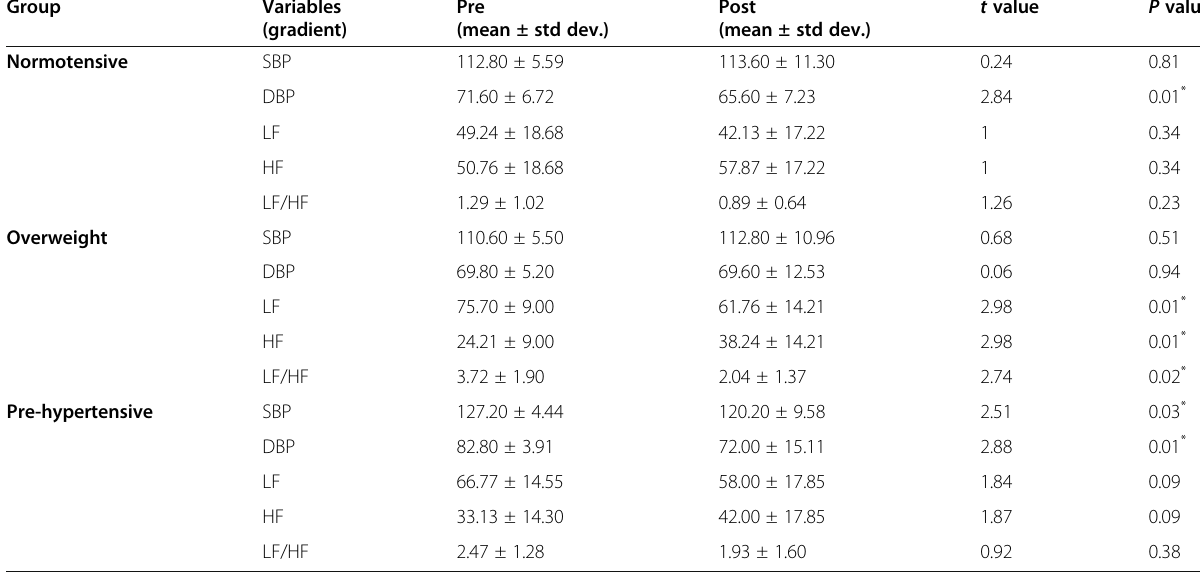
t value P value